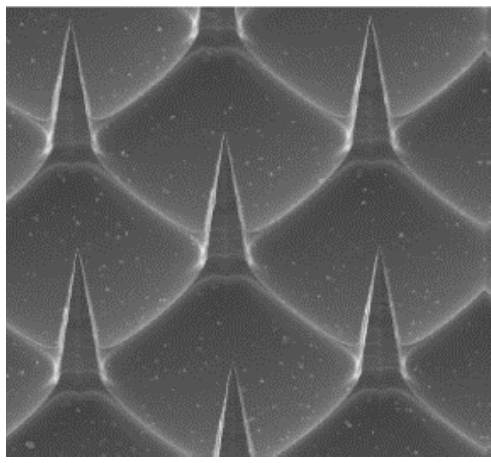
Figure 5. Scanning electron microscopy imaging of DT / TMC (Diphtheria toxoid / N-trimethyl chitosan) coated microneedle arrays [98]. Table 3. A summary of studies on the delivery of vaccines using dissolving microneedles.